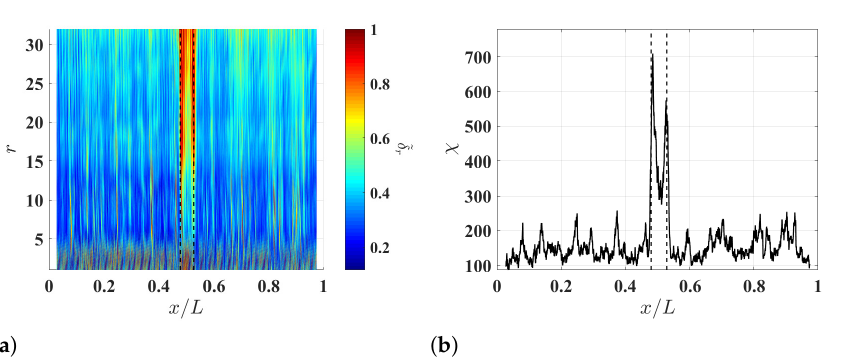
Figure 12. ( a ) Multi-resolution auxiliary TSCDI ˜ δ r associated with δ l − r , r with r = 1,2, . . . ,32 and ξ = 5% and ( b ) the auxiliary CDI χ associated with ˜ δ r in ( a ). Locality and extent of the damage are indicated by two dashed lines.